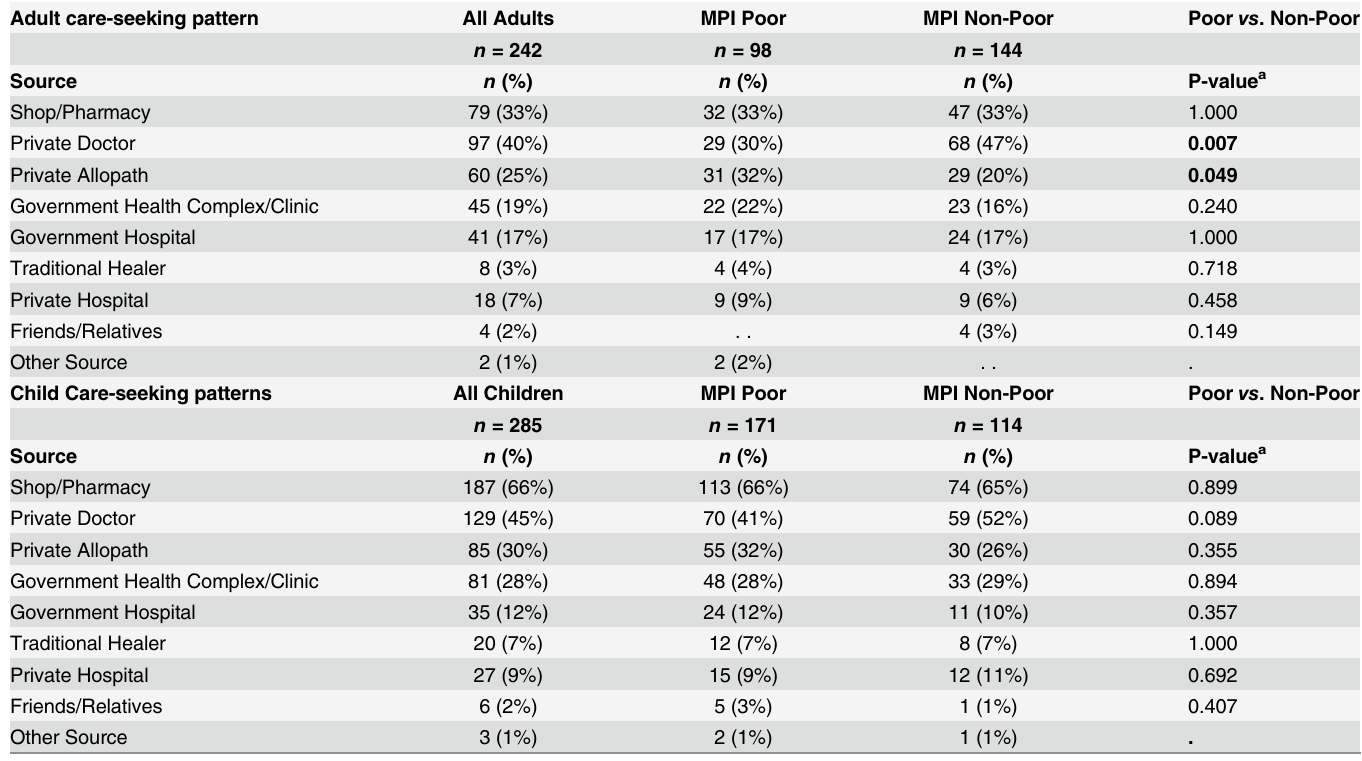
Table 4. Patterns of care-seeking among poor and non-poor adults and